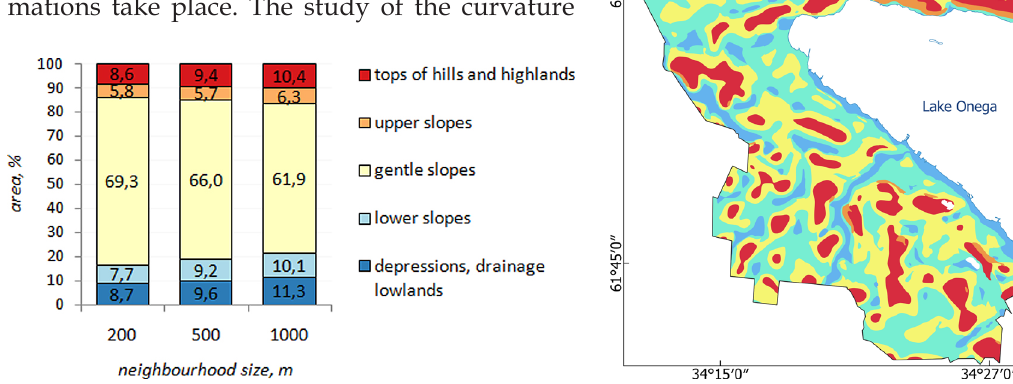
Fig. 8. Elementary landscapes. Decoding of indices in Table